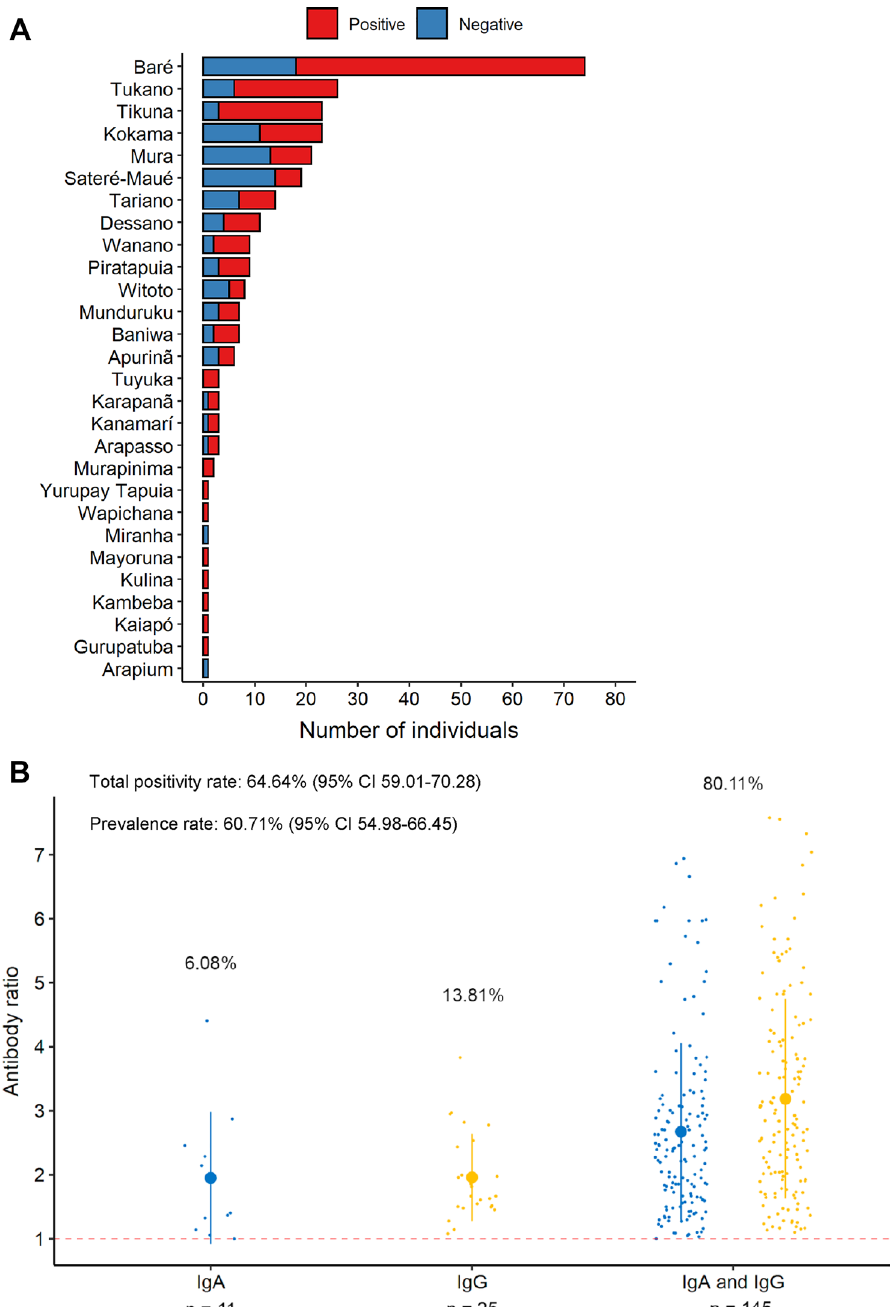
Figure 2. Ethnic diversity of the study population and positivity rates. ( A ) SARS-CoV-2 positivity according to ethnicity. ( B ) Pattern of IgA, IgG and IgA/IgG positivity among infected individuals. Smaller dots represent the antibody ratio from each individual. Larger dots and vertical lines represent mean and standard deviation, respectively. Dashed line represent cut-off values specified by the